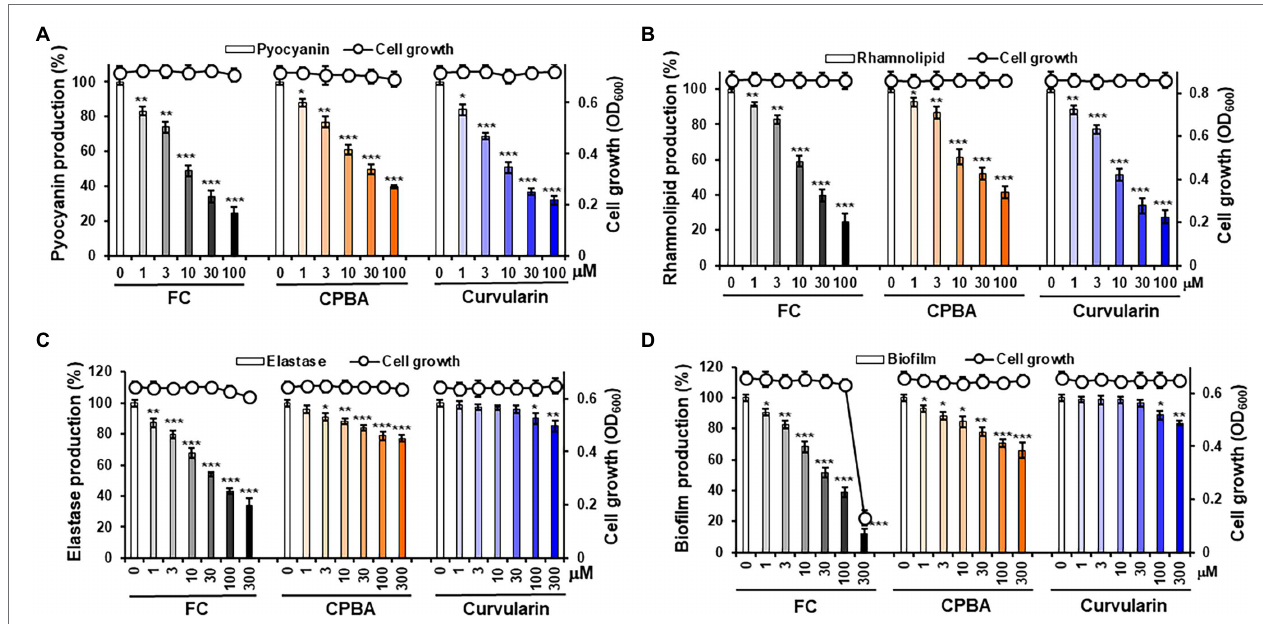
FIGURE 2 | Effects of curvularin on P. aeruginosa virulence factor production and biofilm formation. (A–C) Effects of curvularin on virulence factor production and cell viability in P. aeruginosa PA14. After PA14 cells were grown in LB medium containing various concentrations of curvularin for 24 h, cell density was measured at 600 nm and pyocyanin and rhamnolipid and elastase activity in the culture supernatants were then determined. (D) Effects of curvularin on P. aeruginosa biofilm formation and cell viability. PA14 biofilms were grown in the presence of curvularin for 9 h, followed by the measurement of planktonic cell density at 600 nm. The biofilm cells attached to the well surface were assayed using crystal violet staining. Furanone C-30 (FC) and N-cyclopentylbutyramide (CPBA) are known antagonists of LasR and RhlR, respectively. Three independent experiments were performed in triplicate, and the mean ± SD values are presented in each bar. * p < 0.01; ** p < 0.001; and *** p < 0.0001 versus untreated